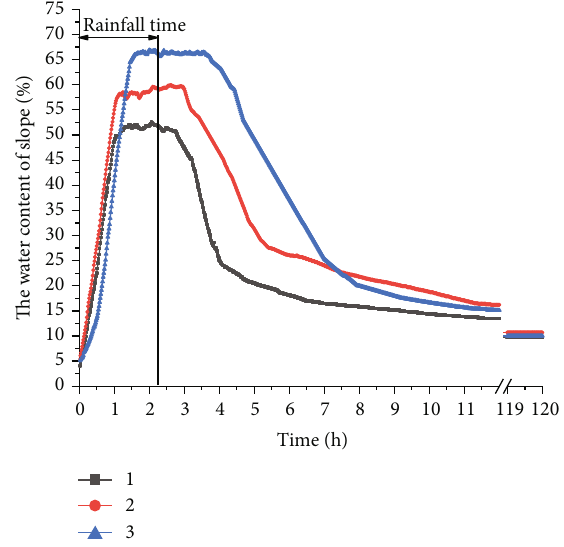
Figure 19: The changes of the upper slope water content with time.